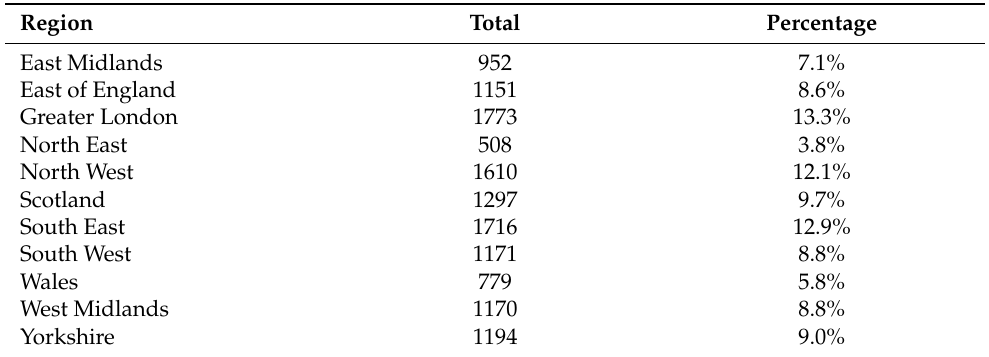
Table A2. Number of participants in each region and percentage of the SERL Observatory sample.